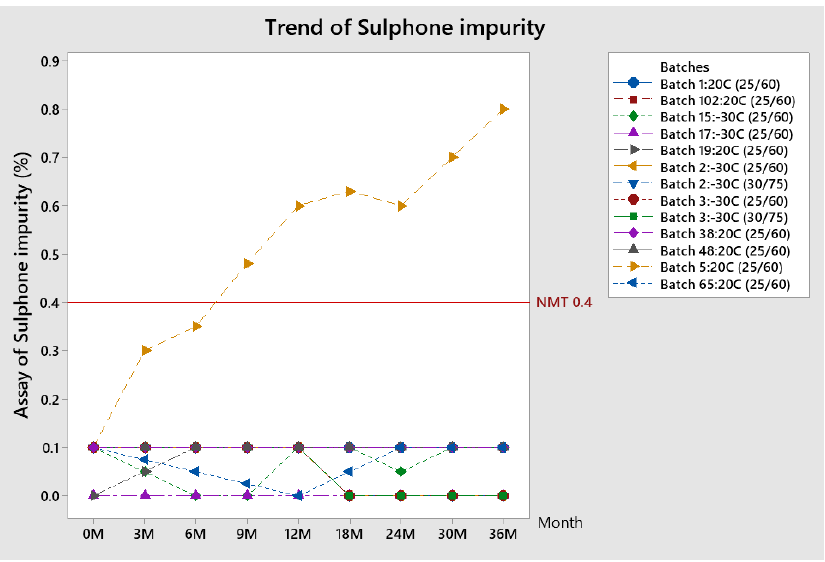
Figure 7. Trend of Sulphone impurity during the stability study.